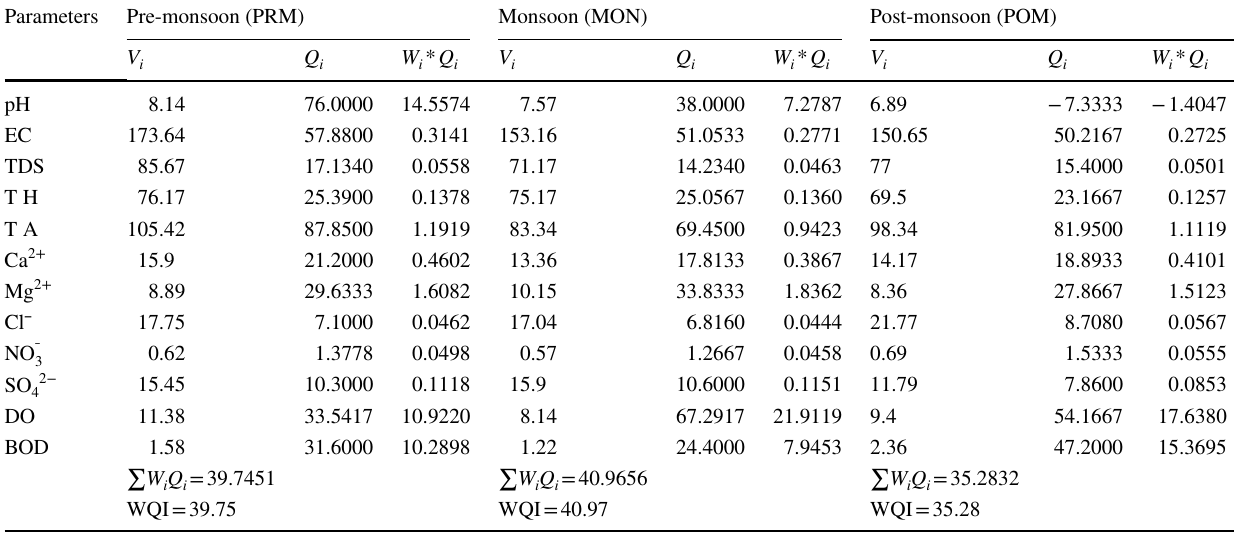
Table 12 Calculation of WQI at station 8 (S 8) Parameters